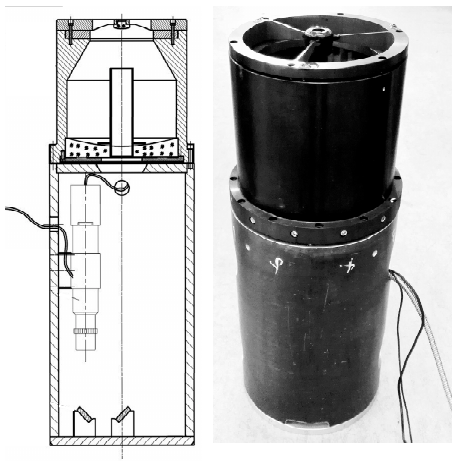
Figure 4. Microscopic measurement integrated Figure. 4. Microscopic measurement integrated device.